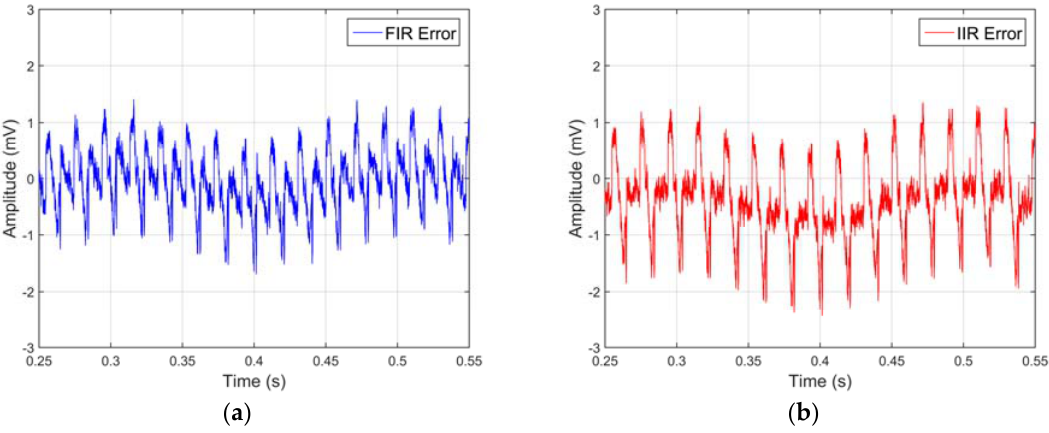
Figure 7. Difference between input raw data and FIR/IIR filters responses. ( a ) FIR response difference error; and ( b ) IIR response difference error.